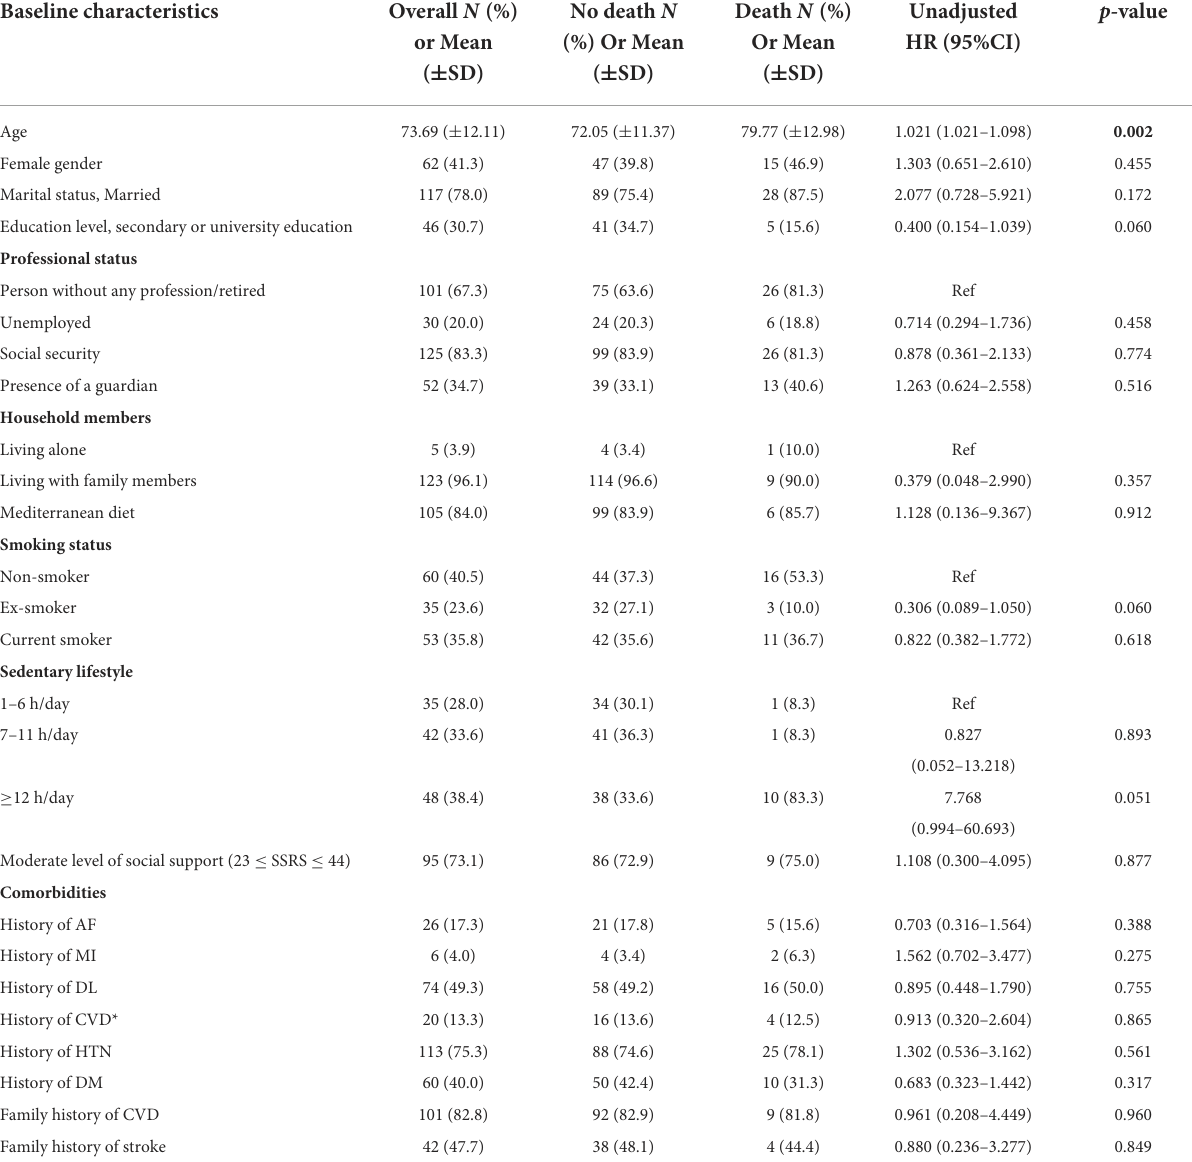
TABLE 6 The association of baseline characteristics with 1-year any-cause of death post-stroke using cox proportional hazard regression univariate analysis. Baseline